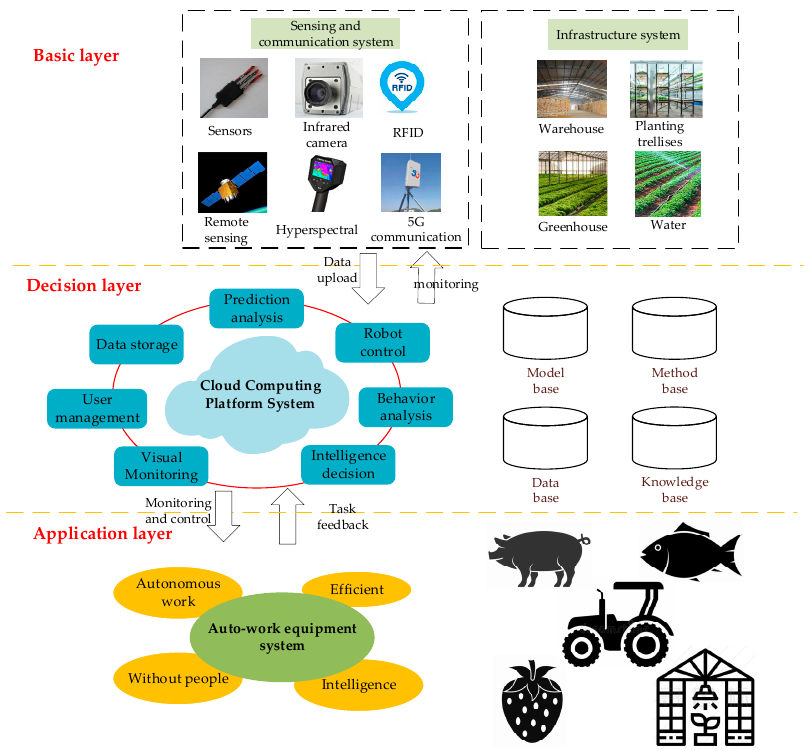
Figure 1. Conceptual unmanned farm system architecture showcasing various elements and interactions.